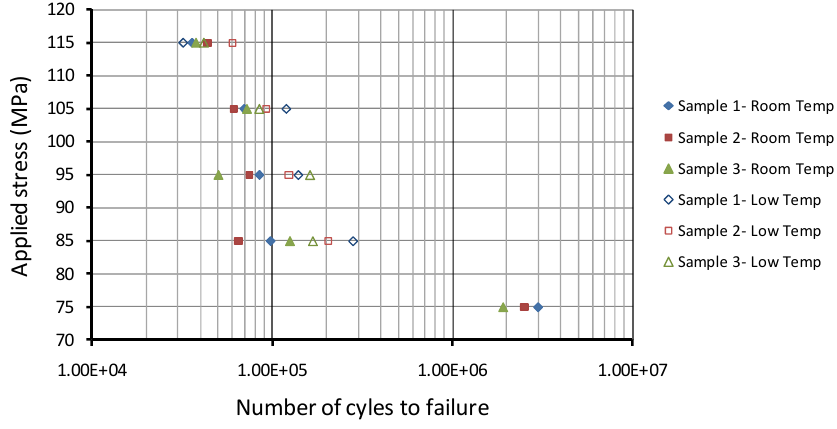
Figure 29. Fatigue life results at room and cold temperature